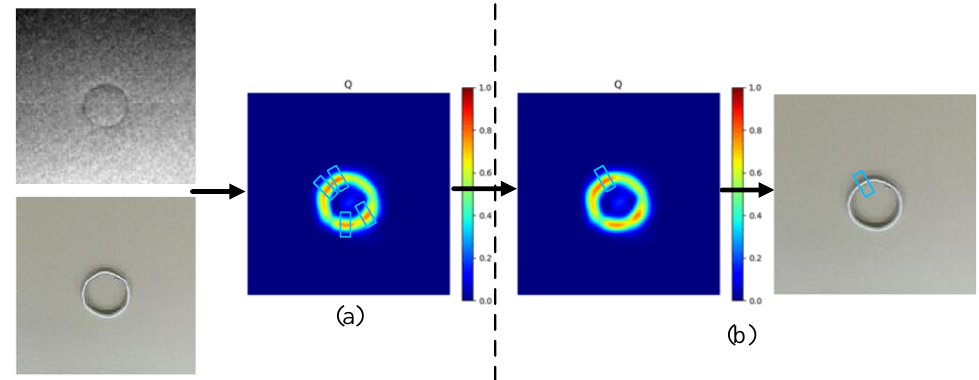
Figure 4. Pixel-level grasping. ( a ) Multiple grasping rectangles in multiple grasping regions, and the center of grasp rectangle is the local maximum. ( b ) The pixel point with the global maximal grasp quality is the center of the predicted grasping rectangle.